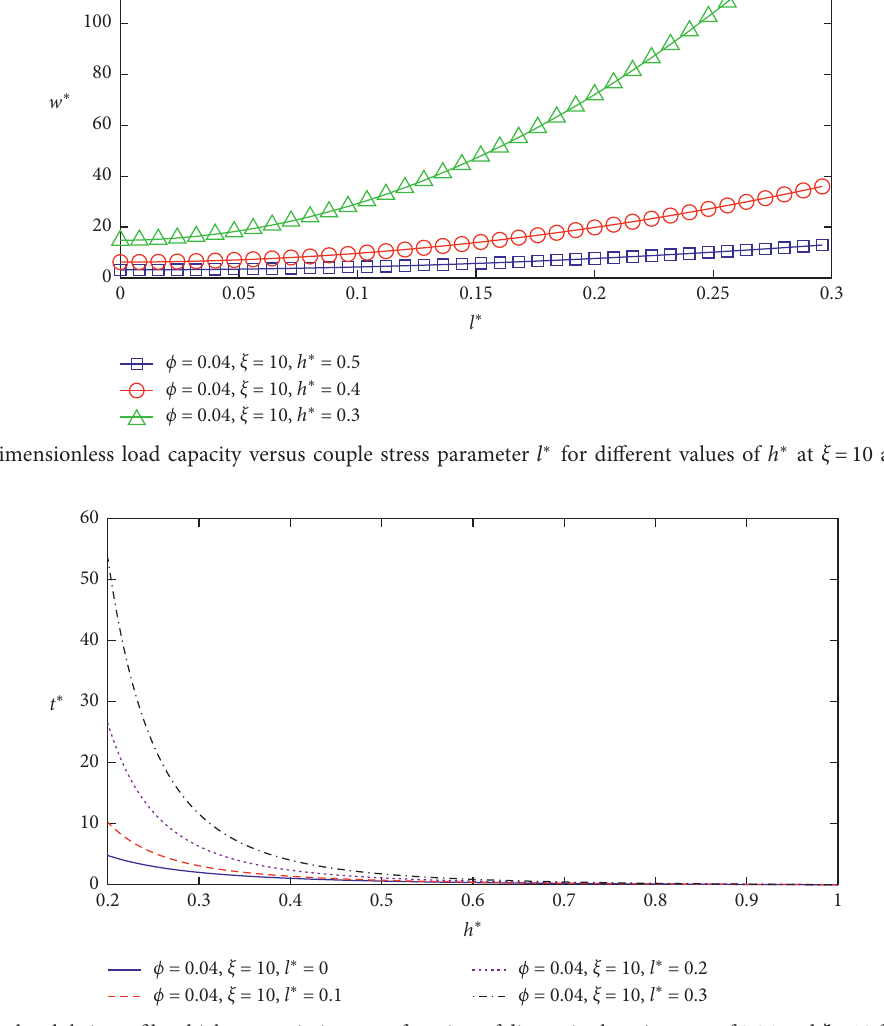
Figure 7: Dimensionless lubricant film thickness variations as a function of dimensionless time at s of 0.04 and ξ � 10 for different values of l ∗